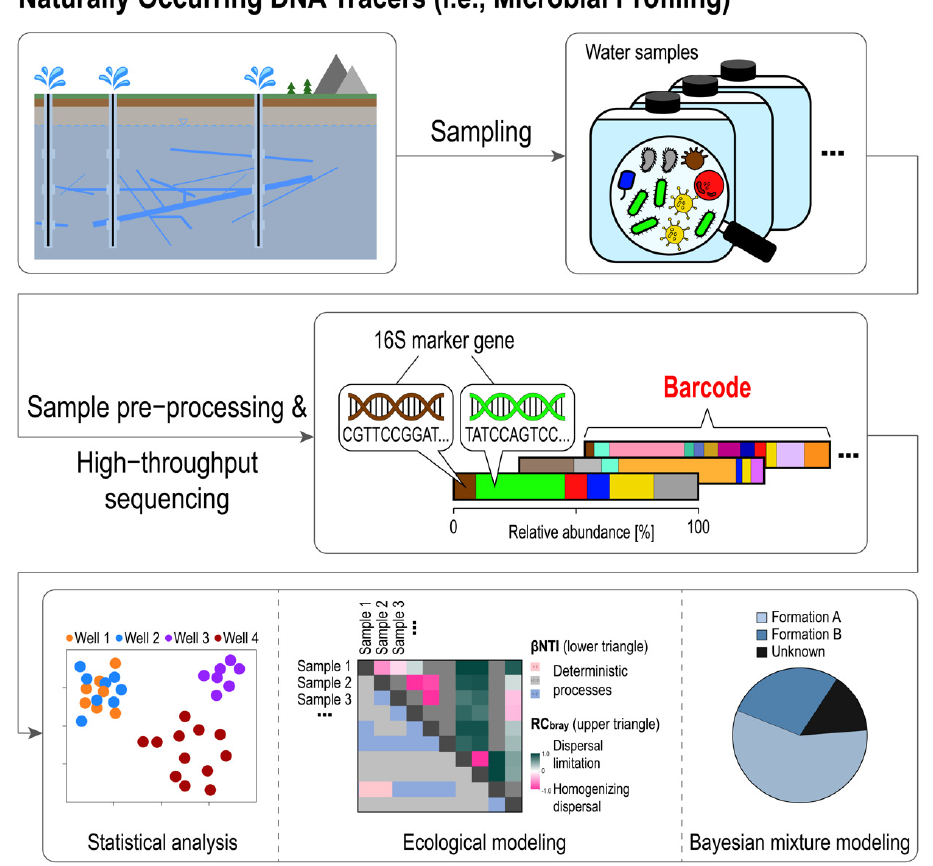
Figure 2. Schematic illustration of naturally occurring DNA-based tracer methods. The composition of the entire microbial communities inhabiting reservoir fluids (presence/absence and relative abundance based on the 16S rRNA marker gene sequences) can be utilized, with the help of statistical methods, to correlate microbial community patterns with the structure of subsurface flow